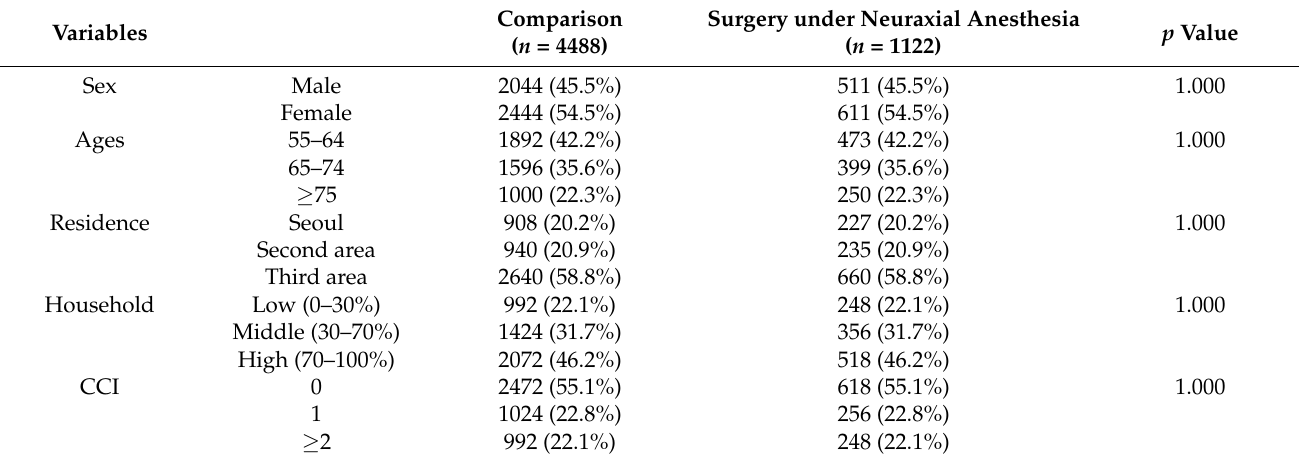
Table 1. Characteristics of the study